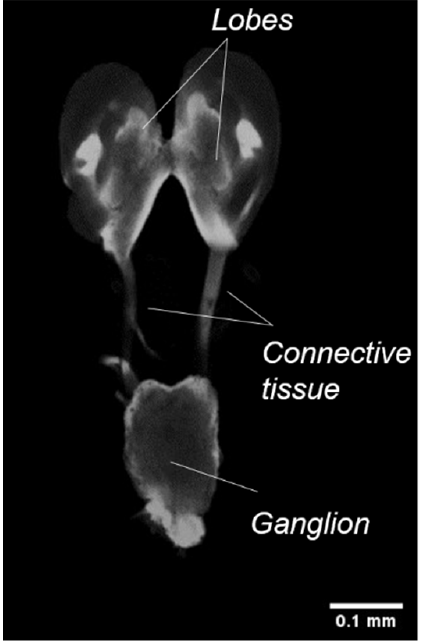
Figure 8. Visualisation of the pupal brain in different confocal sections from most anterior ( A ) to most posterior ( D ) stained with synapsin. ( A ) Mushroom body lobes (MB-lb), anterior optic tubercles (AOTu), and antennal lobes (AL). ( B ) Central body (CB) and accessory medulla (aMe). ( C ) Medulla (Me) and lobula (Lo). ( D ) Mushroom body calyx (MB-ca) and pro- tocerebral bridge (PB).